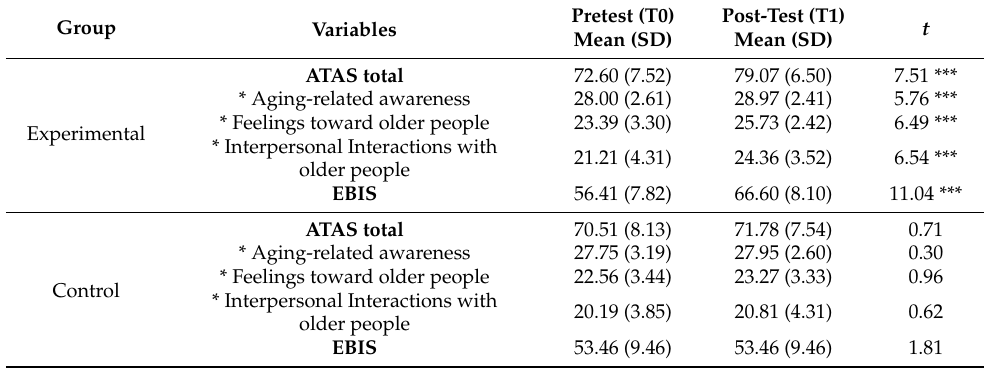
Table 3. Efficacy variable score paired t -value test after educational